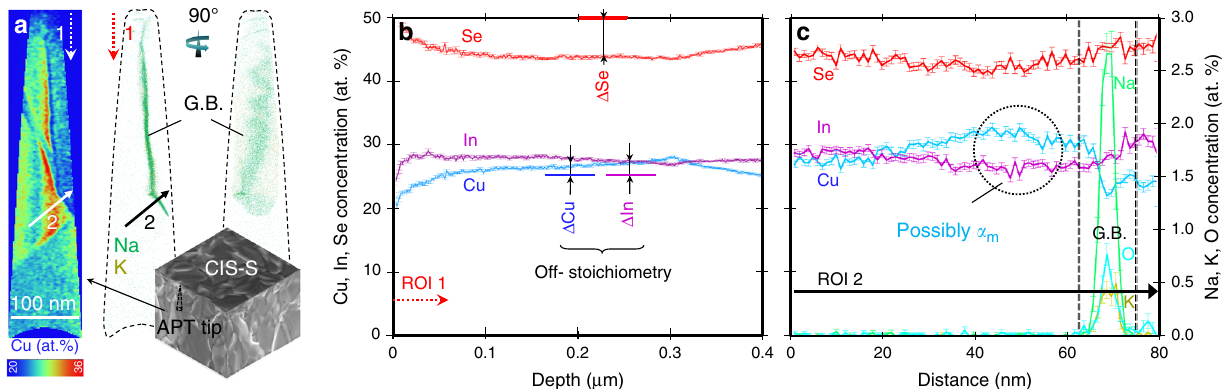
Fig. 2 Atom probe tomography of stoichiometric CuInSe 2 (CIS- S ). a Cu concentration map (cf. Cu atomic % coloured scalebar) and corresponding Na and K elemental distributions, acquired to highlight the location of a grain boundary. The labelled arrows identify orientations of the regions of interests (ROI) 1 and 2. b Integral compositional depth pro fi le from the whole specimen volume with highlighted off-stoichiometry: de fi ciency of selenium ( Δ Se) and excess of copper ( Δ Cu) and indium ( Δ In) with respect to stoichiometric CIS (50 at.% Se and 25 at.% In and Cu). c Compositional pro fi le along ROI 2, revealing a portion with Cu concentration far exceeding stoichiometry (dotted